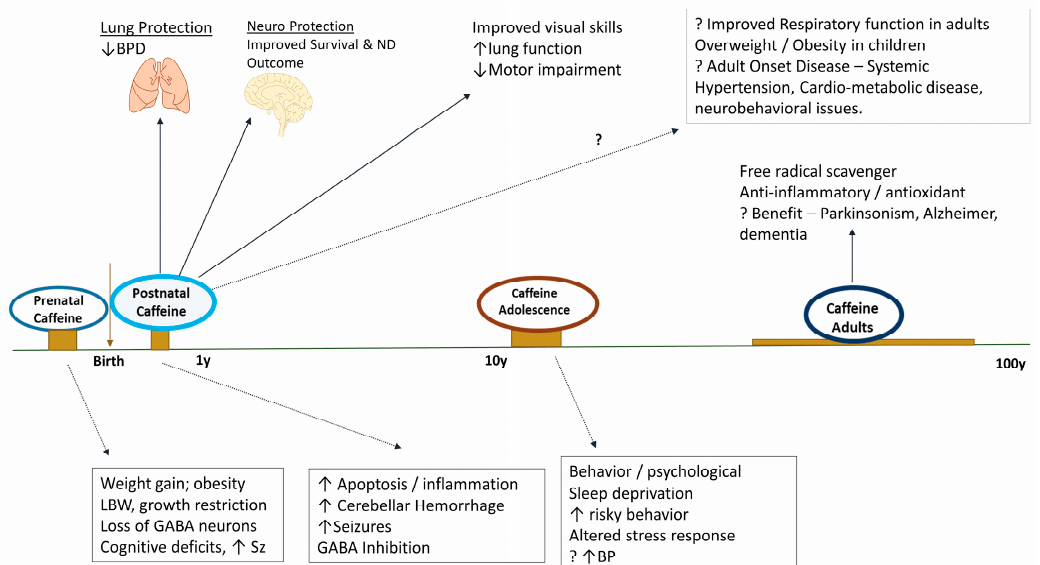
Figure 2. The spectrum of effects when caffeine is consumed prenatally, postnatally, and during adolescence. Caffeine consumed during pregnancy and adolescence may have adverse